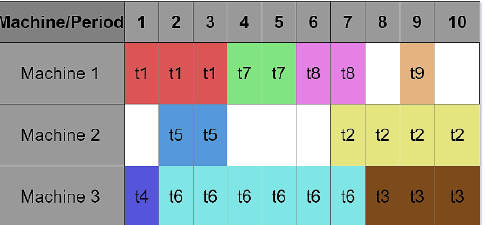
Figure 3. Example of an individual matrix (machine/period), from the genetic algorithm, where tasks are identified by colors and their identifiers.